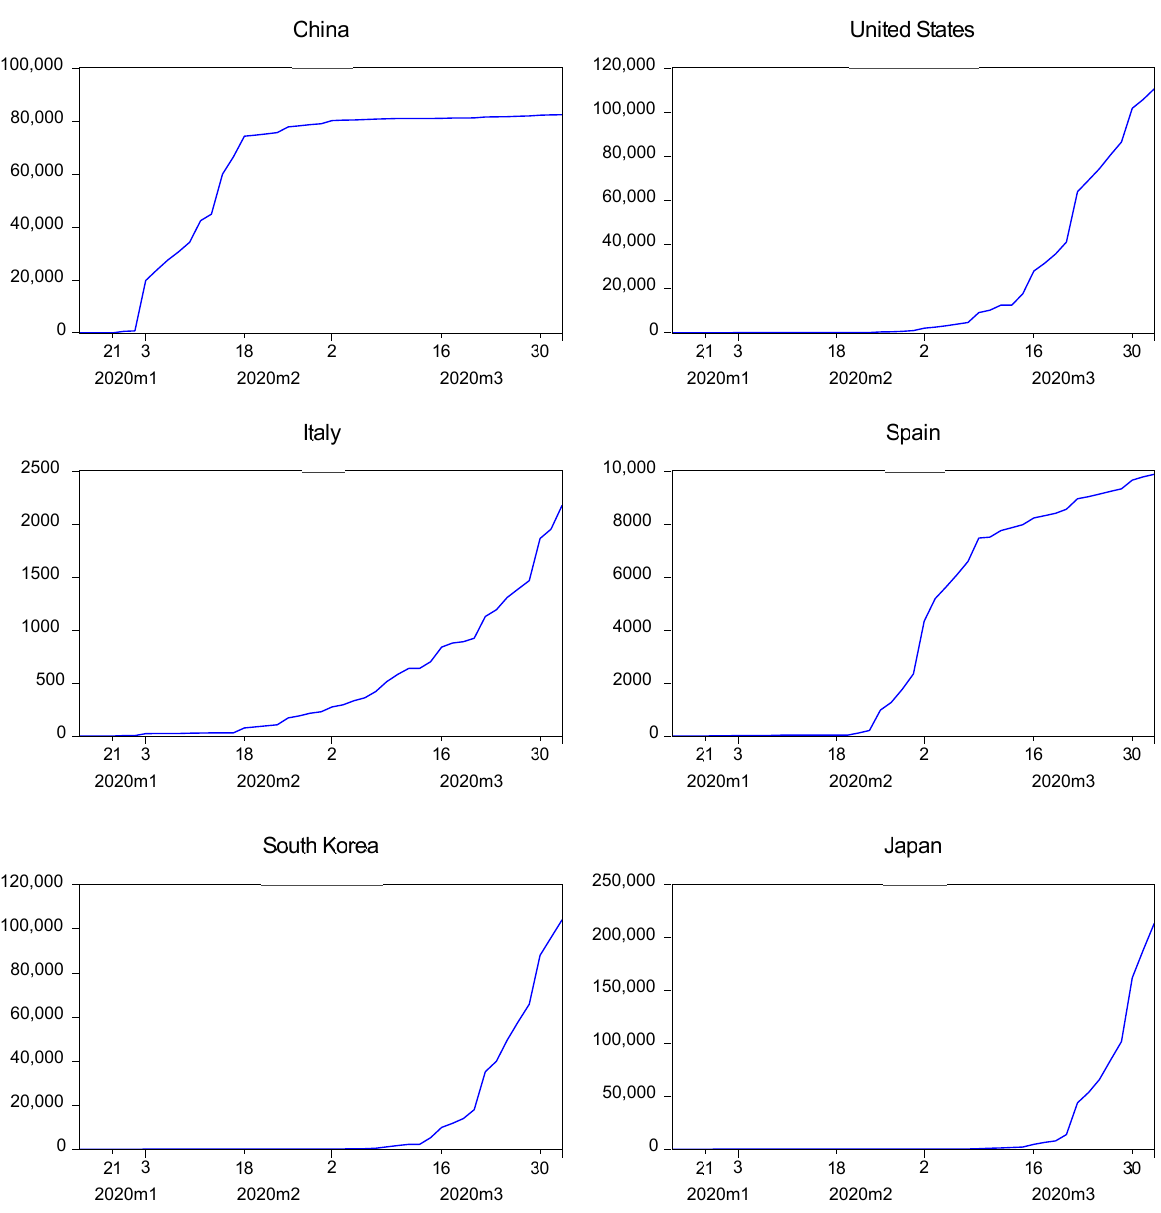
Figure 2. People infected per day with Covid-19. Note: M1 to M3 represents the months from January to March of 2020. The numbers in the X-axis covers the days within the months. Source: CSSE (2020).